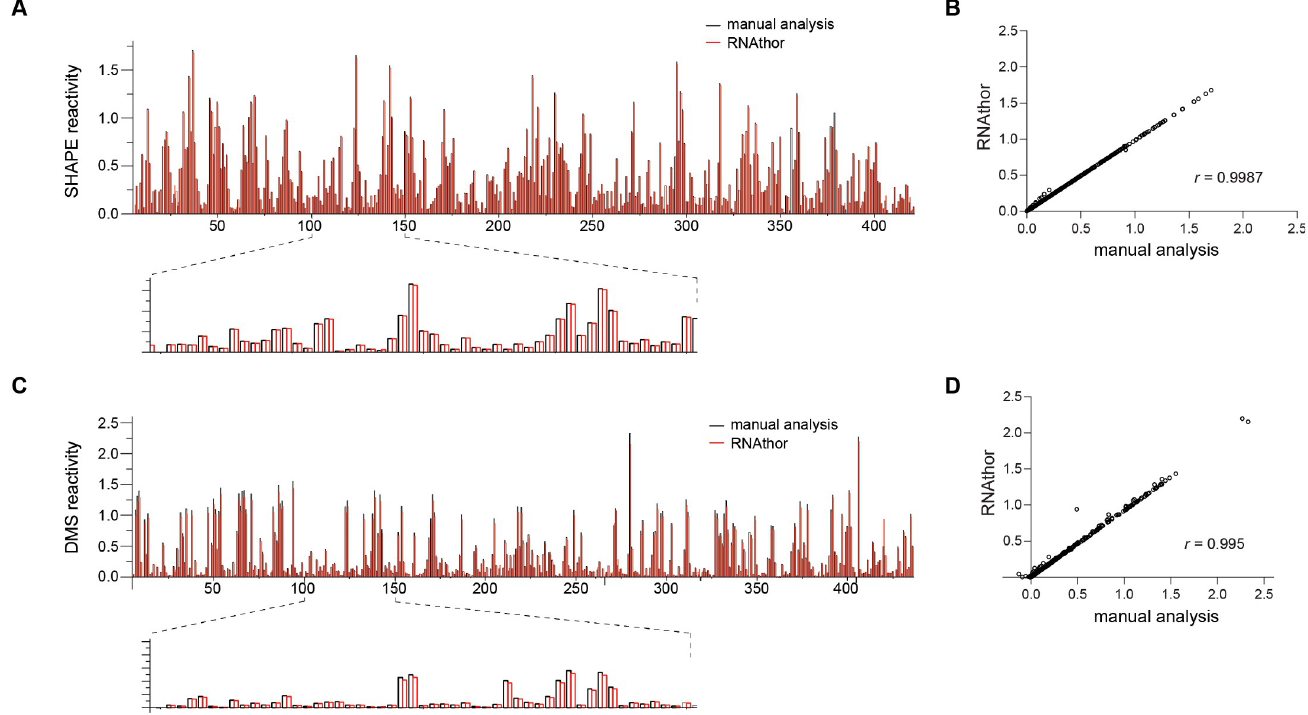
Fig 3. Automatic and manual normalization of RNA probing data. SHAPE (A) and DMS (C) reactivity profiles calculated by RNAthor (red) and manually (black). Correlation between RNAthor and manual analysis per nucleotide reactivity estimated for SHAPE (B) and DMS (D). https://doi.org/10.1371/journal.pone.0239287.g003 +FP) is a fraction of correctly classified unreliable data, while the precision, PPV = TP/(TP